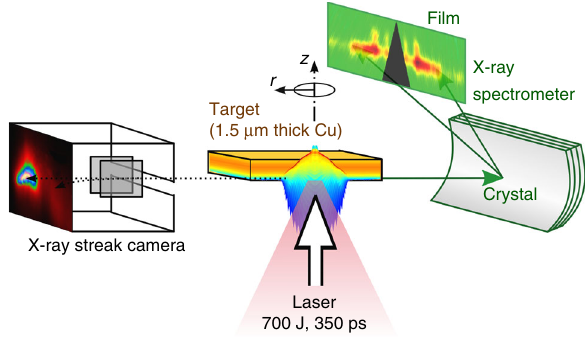
Fig. 1 Experimental setup. The laser beam ( λ ¼ 1 : 315 μ m , I ¼ 4 : 55 ´ 10 15 Wcm (cid:1) 2 ) irradiates a 1.5 – μ m – thick Cu foil at normal